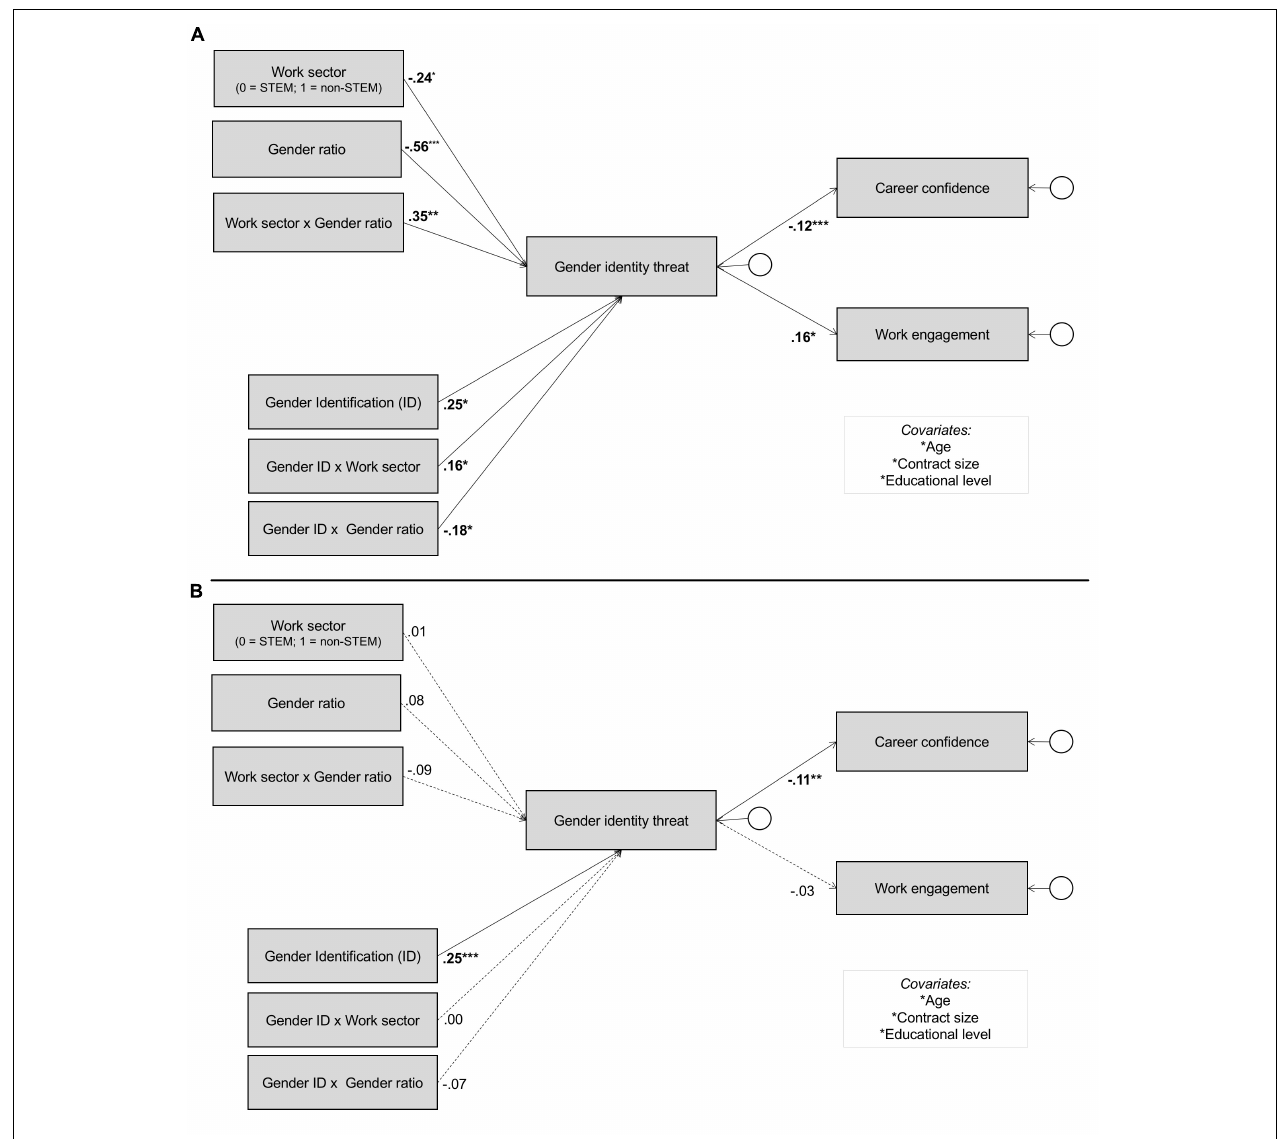
FIGURE 2 | (A) Structural Equation Model for women ( N = 177). Significant standardized parameter estimates marked in bold. (B) Structural Equation Model for men ( N = 630). Significant standardized parameter estimates marked in bold; non-significant standardized parameter estimates are indicated with a dotted line.